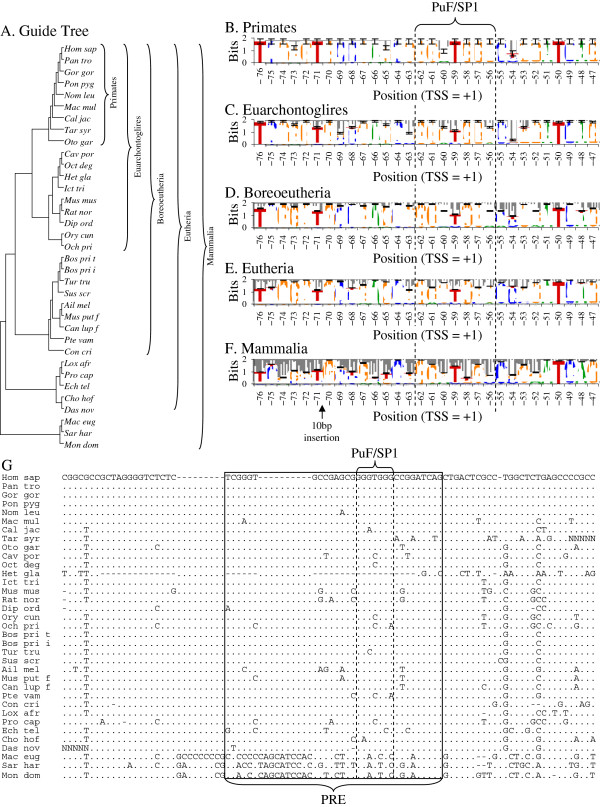
Taxonomic guide tree, sequence logos for the PRE for five ascending clade levels from primates through mammals, and DNA alignment immediately surrounding the PRE. A. The guide tree used for multiple sequence alignment with WebPrank[44]. Guide tree was assembled based on recent phylogenetic analysis of higher organization of mammals [46-49]. B–F. Sequence logos were calculated by conventional methods [50], with sequences taxonomically weighted as described in the main text. Membership in successively nested clades for each species is indicated. The location of the PuF/SP1 site is indicated for all logos. Error bars represent estimated standard deviations of Ri. Logos were calculated for B. primates, C. Euarchontoglires, D. Boreoeutheria, E. Eutheria, and F. Mammals. Sequence specificity for the PRE and the PuF/SP1 site are preserved throughout placental mammals. G. The region of the alignment immediately around the PRE. The PRE is indicated with a solid box, and the PuF/SP1 site is indicated with dashed lines.